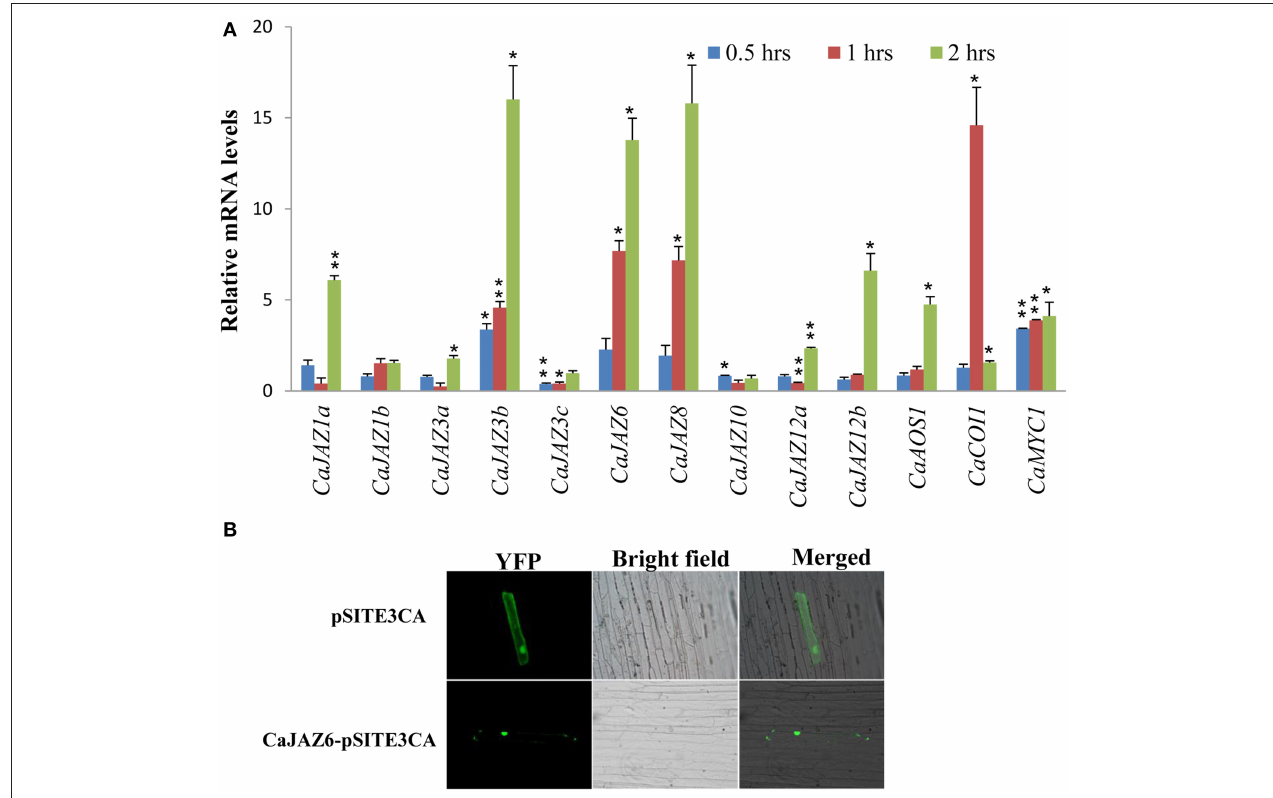
FIGURE 3 | Expression profile of CaJAZs, CaAOS1, CaCOI1, and CaMYC1 genes in response to JA treatment (A) and subcellular localization of YFP:CaJAZ6 fusion protein (B). Expression was studied in methyl JA-treated root tissue using qRT-PCR. Chickpea EF1-alpha gene was used as endogenous control. Error bars indicate standard error of mean. Particle bombardment method was used for transforming the onion epidermal cells using DNA coated gold particles. Transformed cells were visualized under a florescence microscope. ( * p < 0.05 , ** p < 0.01 ).